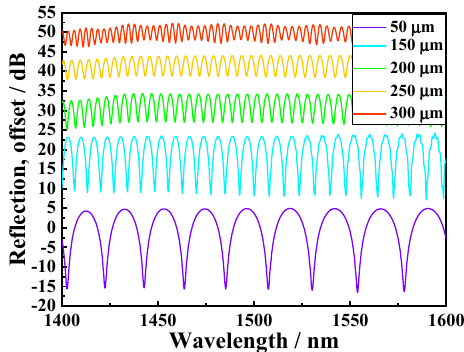
Figure 2. Reflection spectrum of F–P cavities with different lengths.